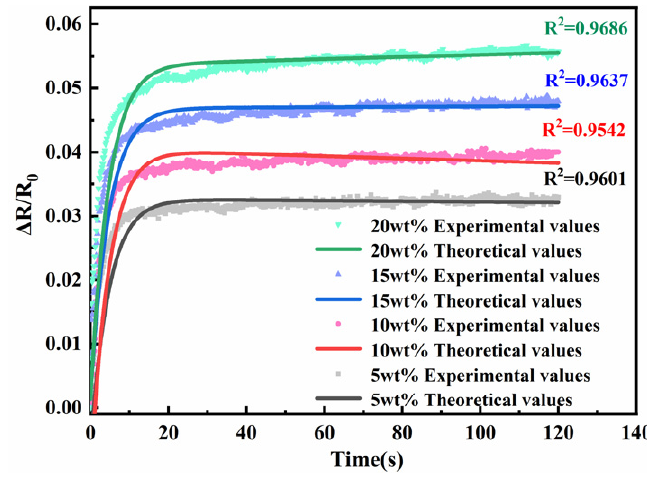
Figure 6. Diagram of nickel powder mass fraction vs. sensing unit resistance creep.